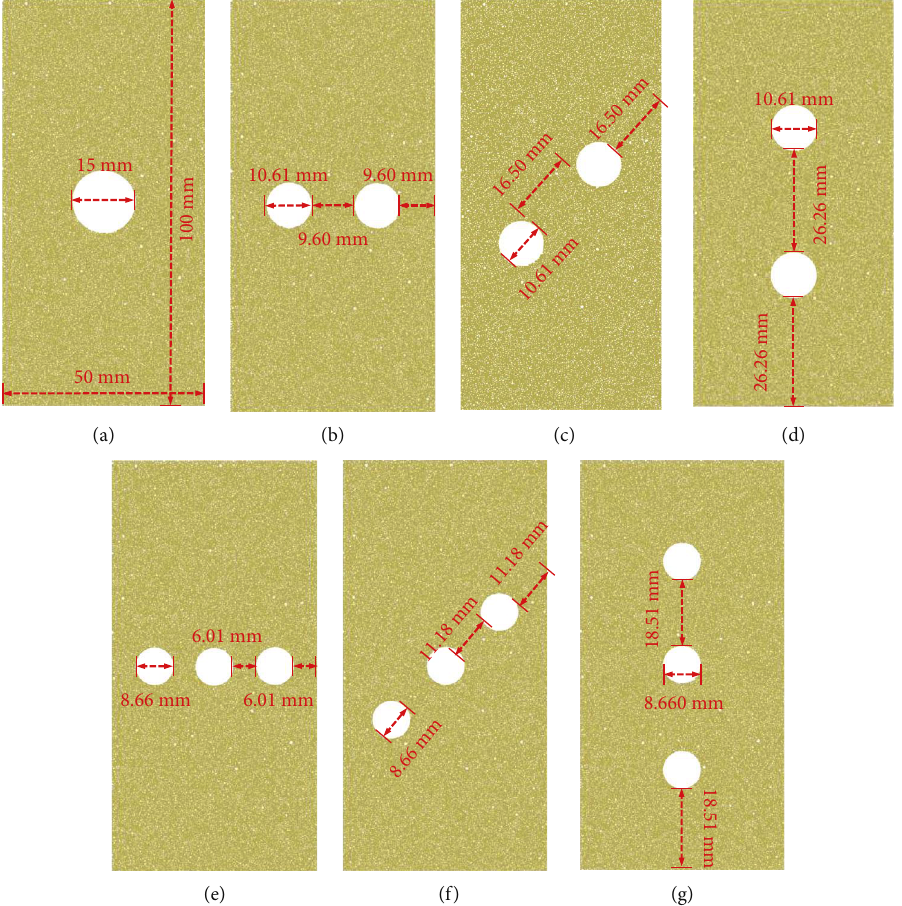
Figure 3: Numerical simulation models: (a – g) represent the numerical models NM-1 to NM-7,